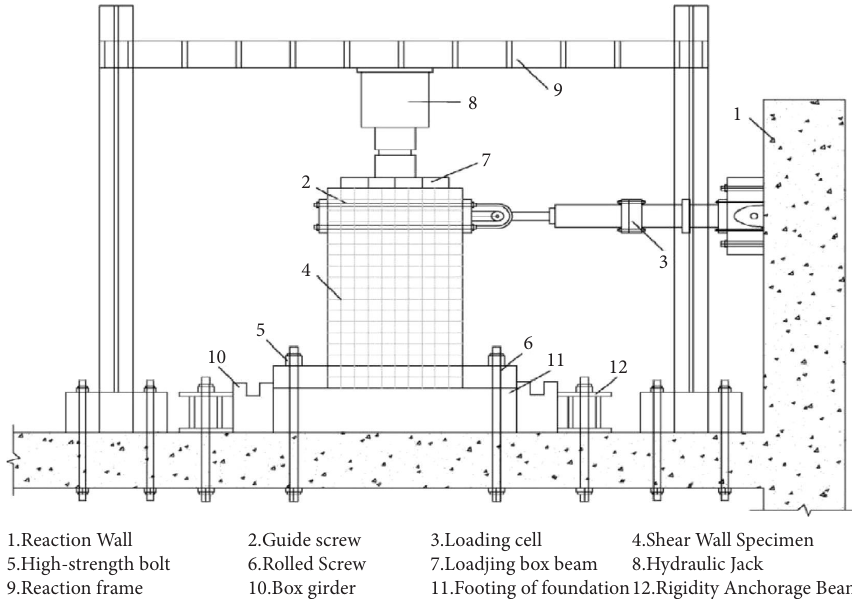
Figure 12: Arrangement of test devices and instrumentation devices.